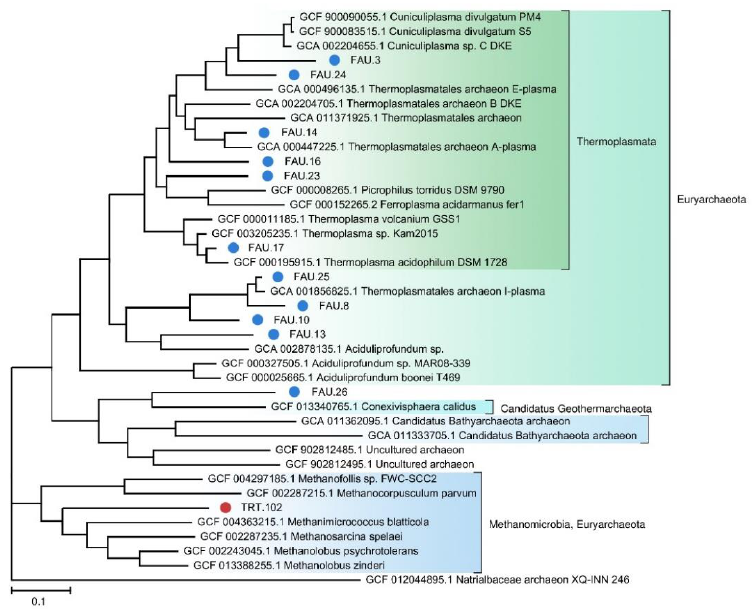
Figure 3. The phylogenetic tree of MAGs affiliated with the Archaea domain. FAU MAGs No. 6, 11, and 18 and TRT MAGs No. 240 and 159 were not placed on the tree because they do not contain enough marker sequences.